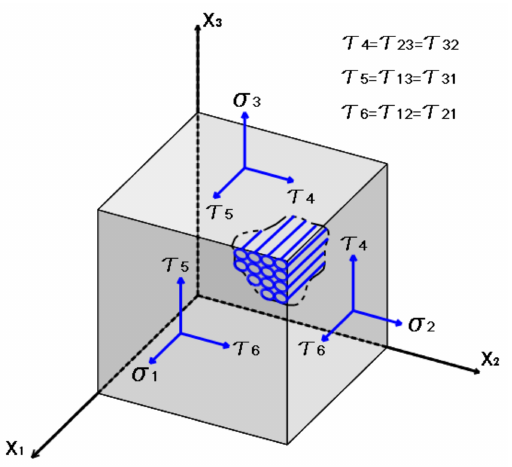
Figure 3. Normal and shear stresses on a single element of the composite material.